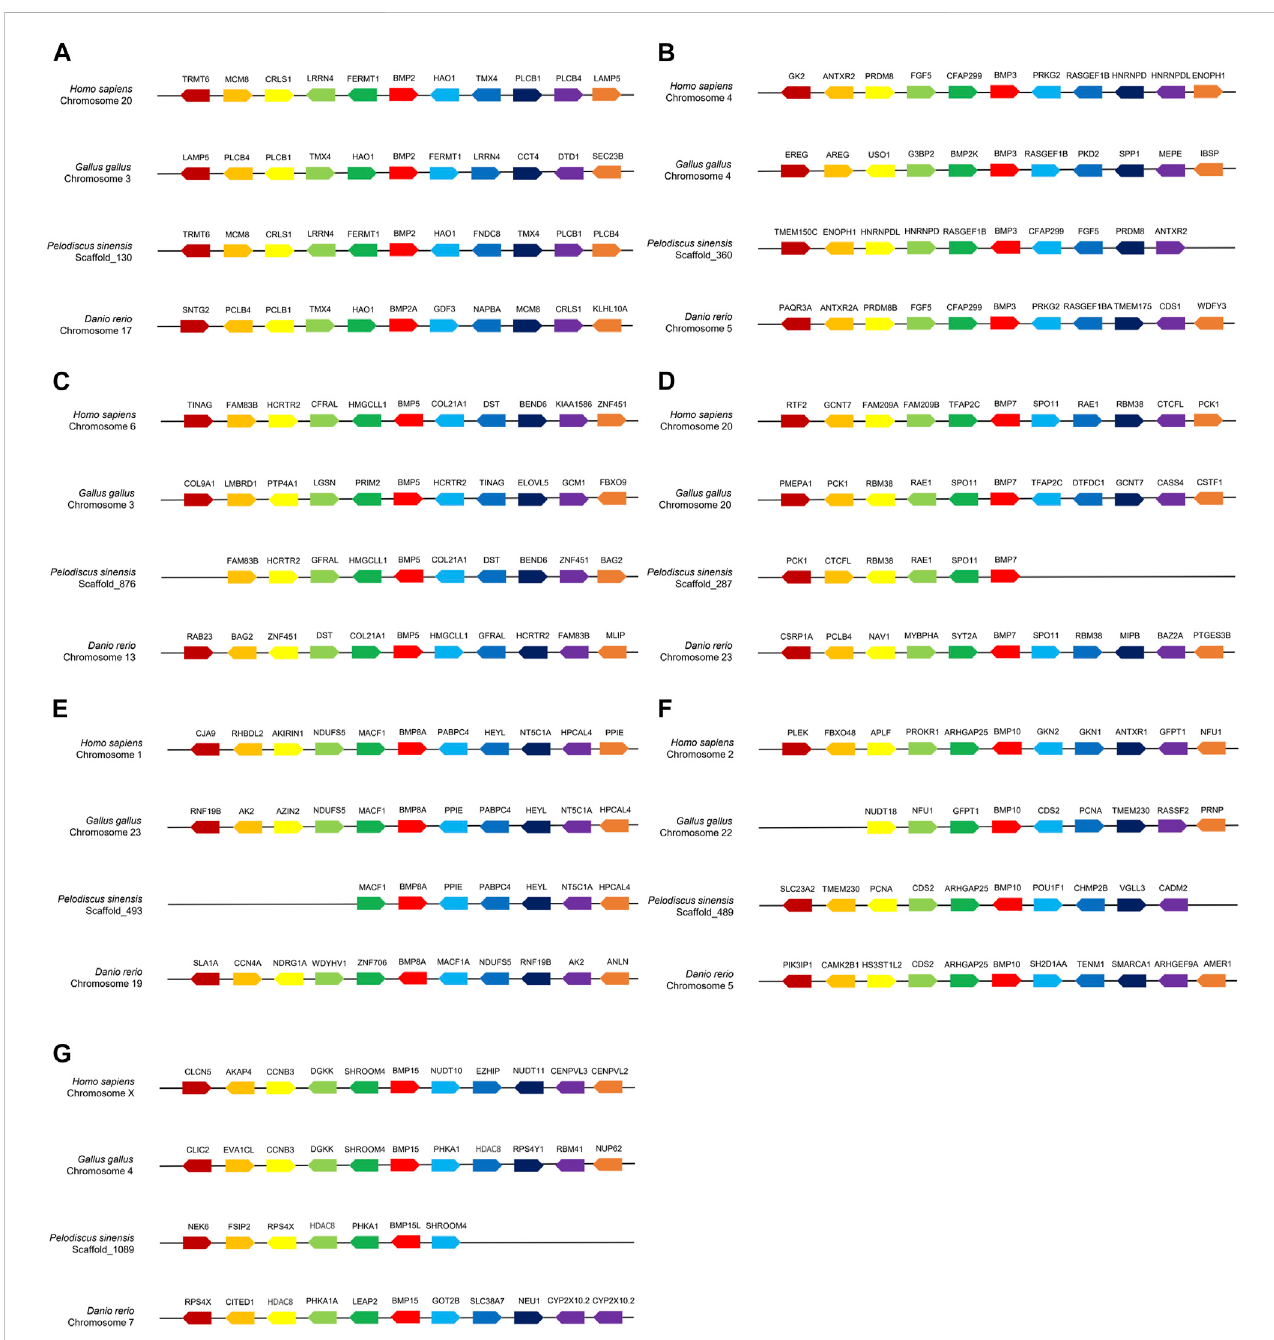
FIGURE 2 Collinear analysis of Bmp2 (A) , Bmp3 (B) , Bmp5 (C) , Bmp7 (D) , Bmp8a (E) , Bmp10 (F) , Bmp15 (G) and their adjacent genes in Homo sapiens, Gallus gallus , P . sinensis and Danio rerio . Direction of the arrows indicates gene orientation.